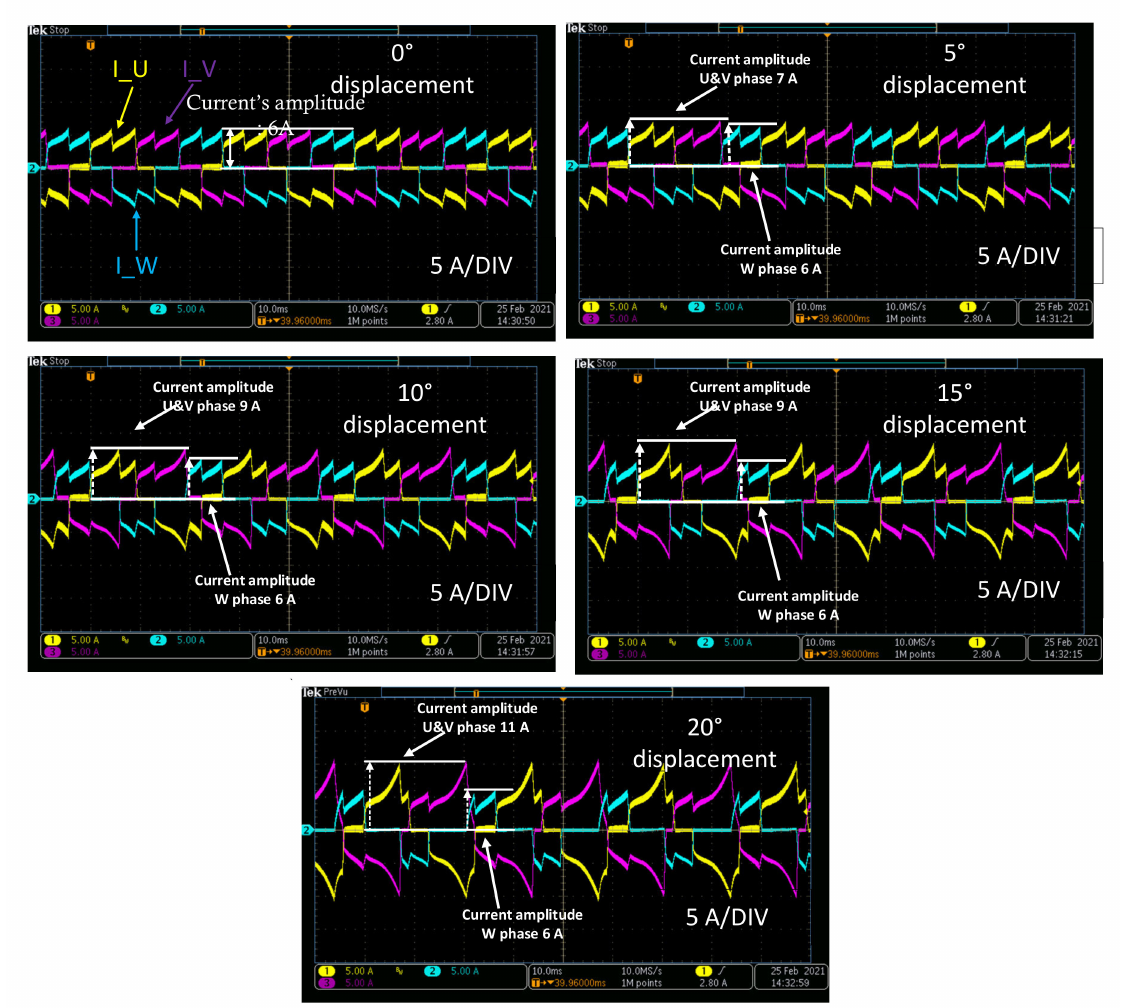
Figure 5. Phase currents waveforms depending on Hall B sensor displacement.